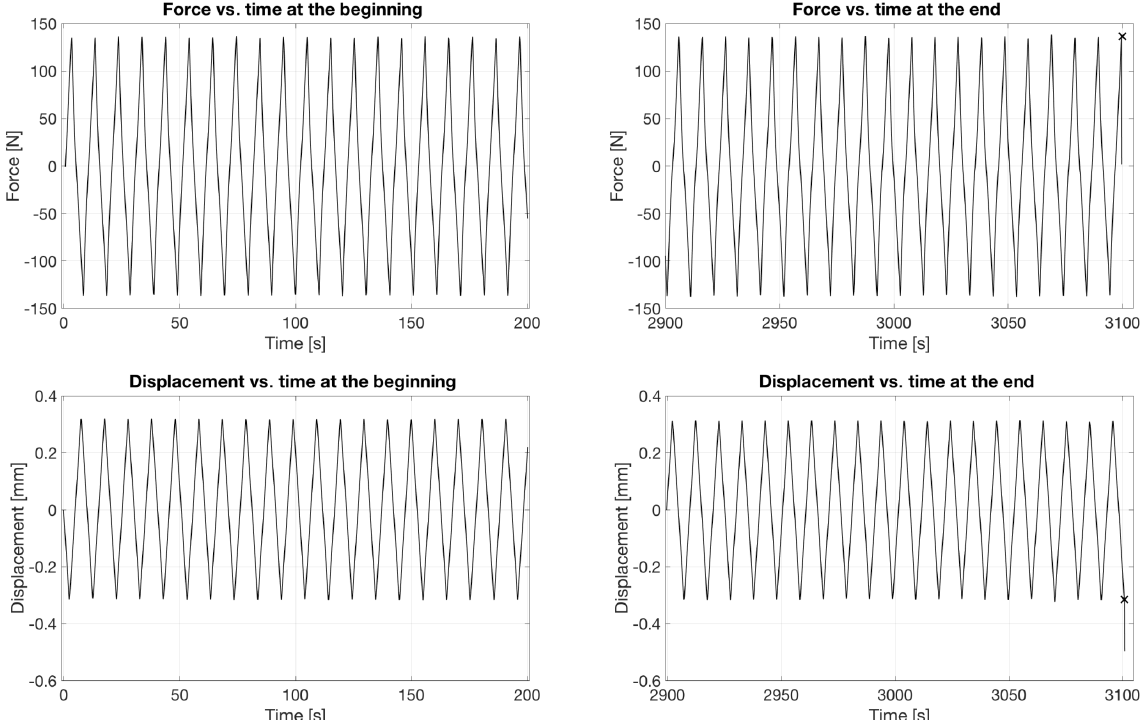
Figure 6. Curves of force/load and displacement vs. time for periods of 200s near the beginning and near the end of cycling before fatigue failure occurred. Marker symbol “x” denotes a moment of specimen failure. Force of ∼ 135N corresponds to ∼